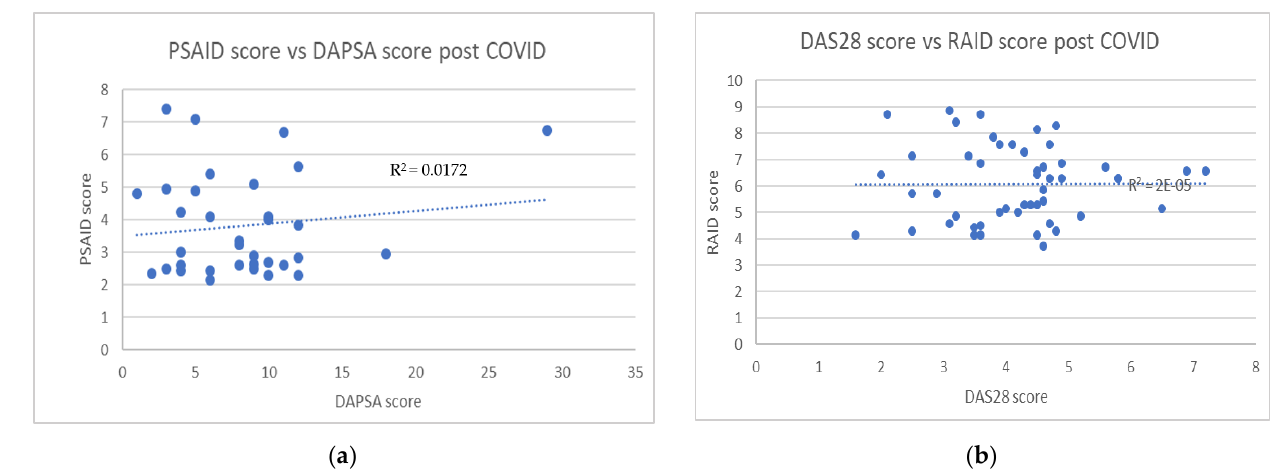
Figure 1. In RA patients ( n = 50), no correlation was found between DAS28 and RAID score (r = 0.112, p = 0.438) ( a ) when comparing values detected before and after the COVID-19 pandemic; likewise, in PsA patients ( n = 34), and no correlation was found between DAPSA and PSAID score (r = 0.131, p = 0.459) ( b ).